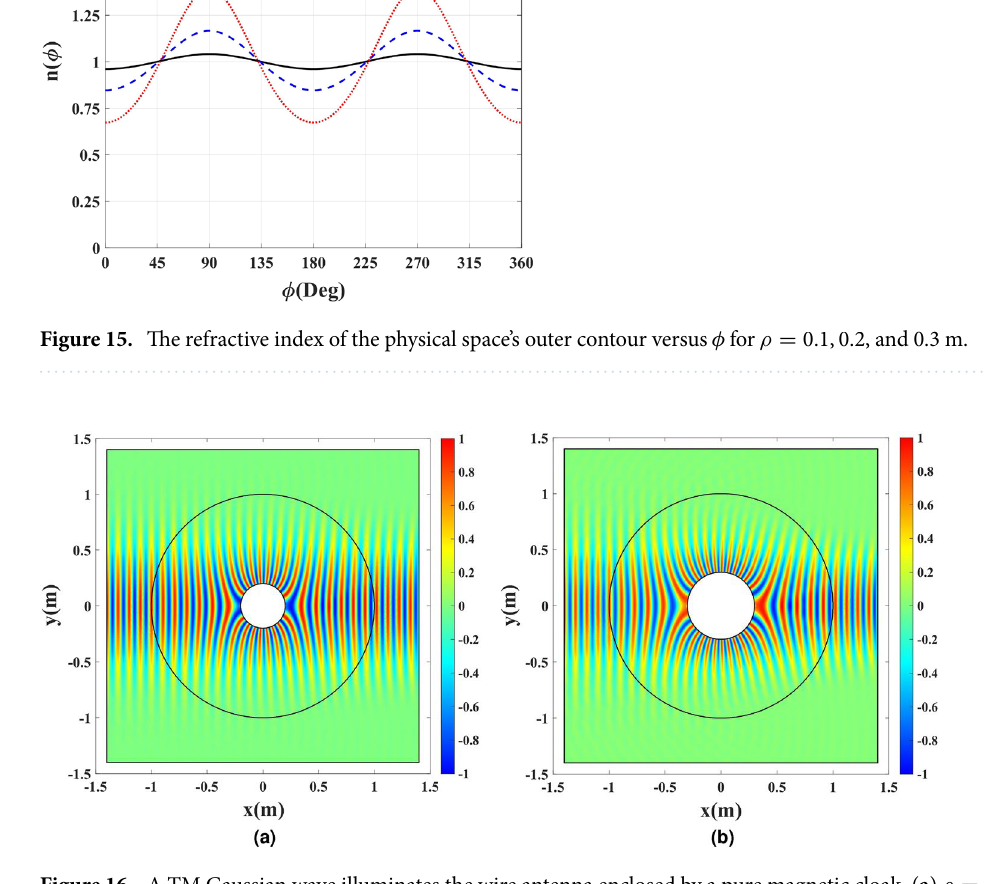
Figure 16. A TM Gaussian wave illuminates the wire antenna enclosed by a pure magnetic cloak. ( a ) ρ = 0.2 m, and ( b ) ρ = 0.3